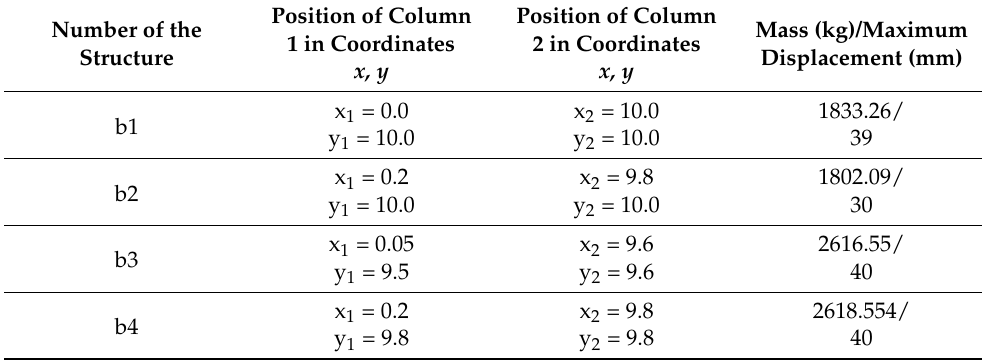
Table 4. The simulation results for the cylindroid structure with a grid pattern of type b (the grid split along longer